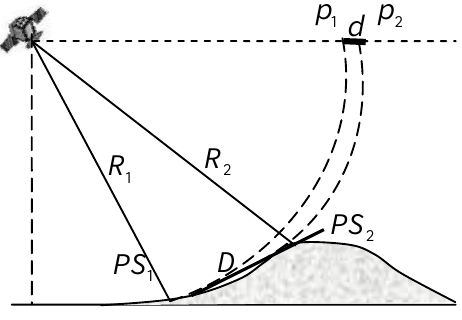
Figure 2. The slant range projection illustration of SAR